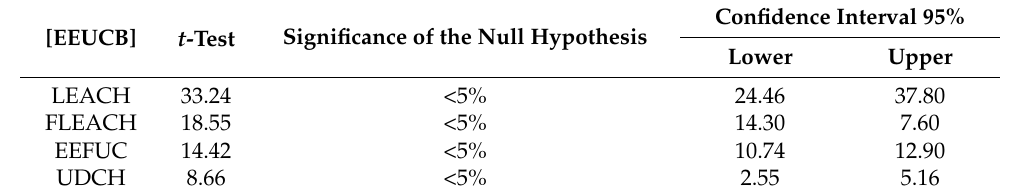
Table 9. Results of t -test for throughput.